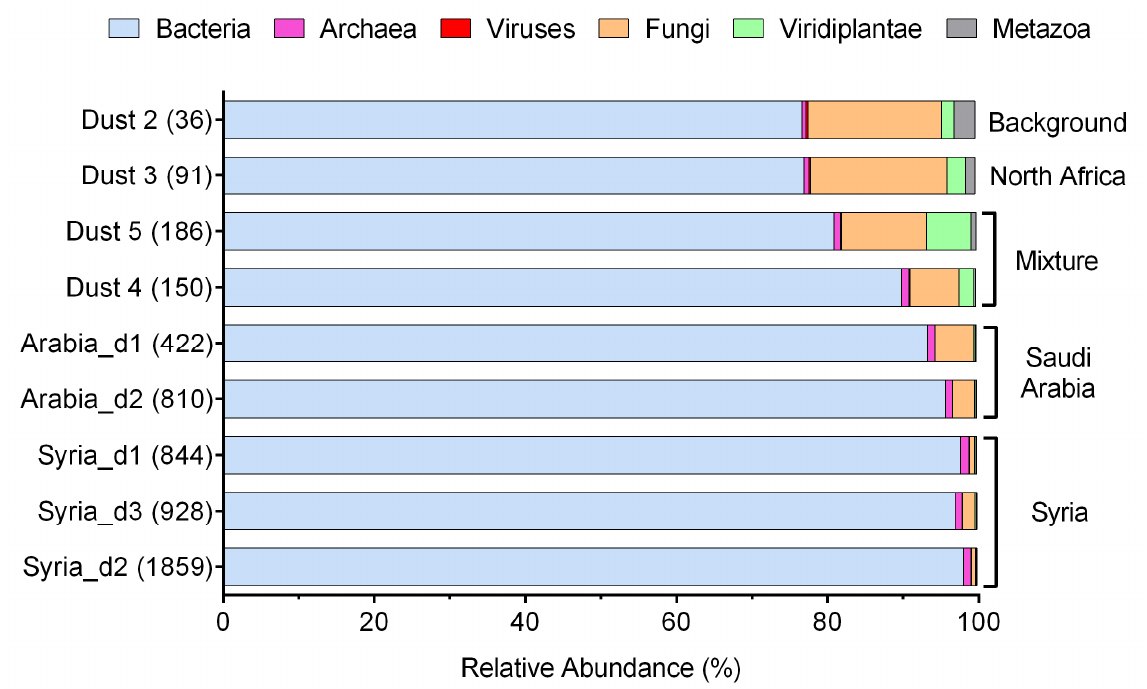
Figure 1. The relative abundance of reads classified by DIAMOND as bacteria, archaea, viruses, fungi, Viridiplantae, and Metazoa in aerosol samples. The numbers in the parenthesis behind the sample number represent PM10 concentrations in μ g m − 3 . The origin of the samples is marked to the right of the stacked bars. Sample “Dust 4” includes a mixture of aerosols originated from North Africa and Saudi Arabia. Sample “Dust 5” includes a mixture of aerosols originated from North Africa, Jordan, and Sinai Peninsula.